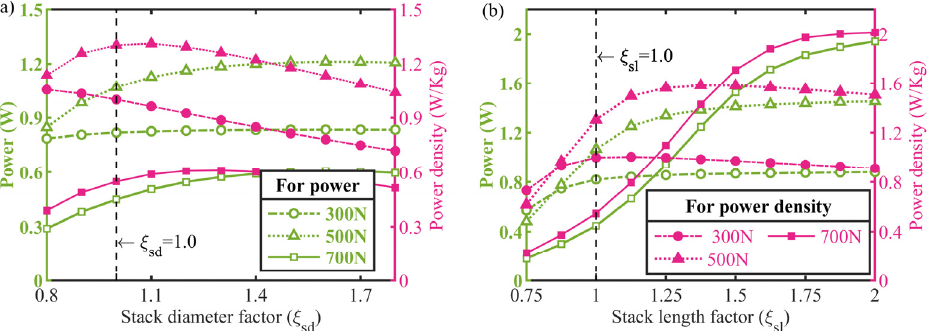
Figure 14. Effects of critical parameters in PZT stack on actuator behaviors. Power and power density versus: ( a ) stack diameter factor, ( b ) stack length factor.